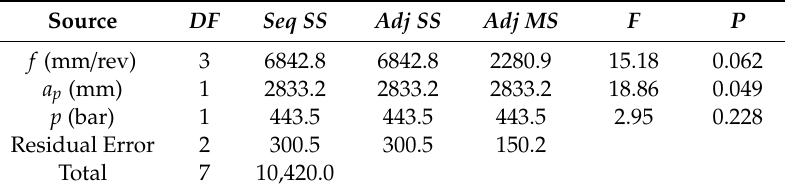
Table 7. Analysis of variance for mean values—thrust force F p.